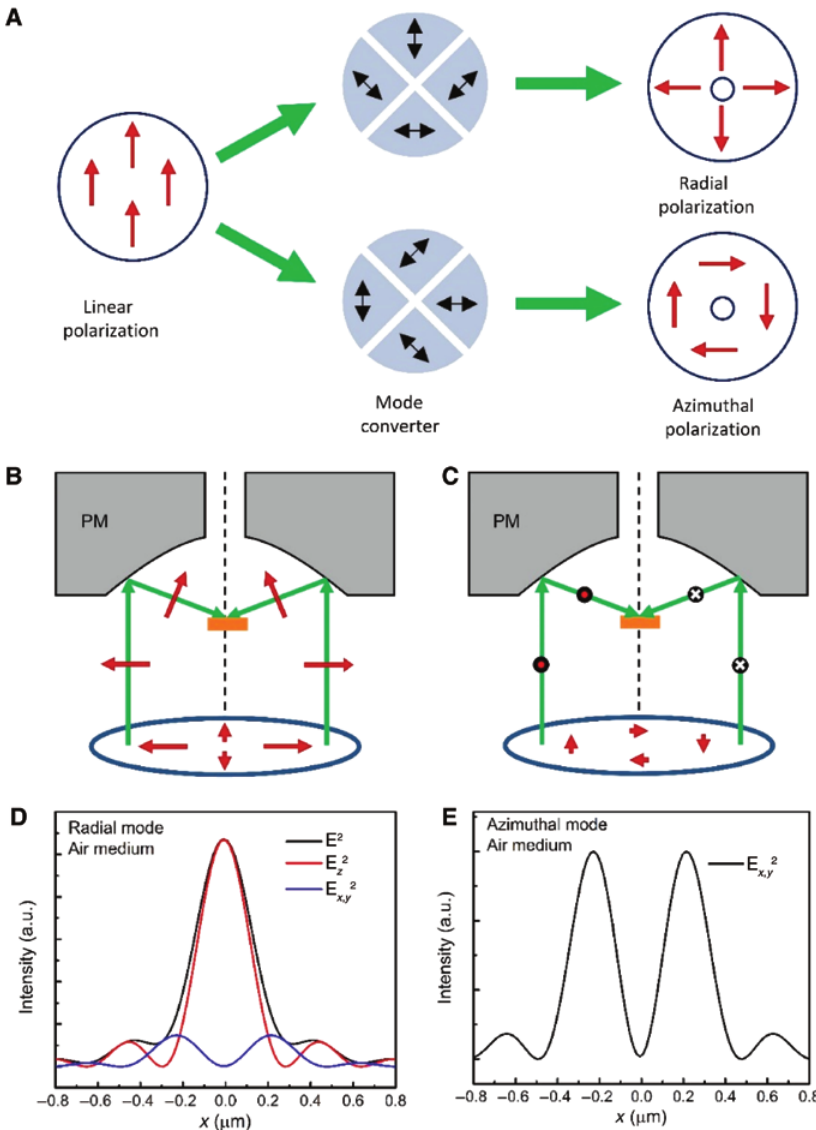
Figure 1: Radial and azimuthal polarization: generation and electric field intensity distribution. (A) Realization of the radial and azimuthal modes from a linearly polarized laser by a mode converter. The red arrows indicate the polarization of the laser beam, and the black two-side arrows stand for the fast axis of the λ /2 wave plate. Parabolic mirror (PM, illustrated as a gray block) focuses (B) the radially polarized laser beam, and (C) the azimuthally polarized laser beam onto the sample (orange block). The green arrows indicate the light propagation direction, while the red ones show the polarization directions. The gray-dashed line is the optical axis of the PM. (D, E) Calculated electric field intensity distributions when a radially polarized beam or an azimuthally polarized beam 2 , E 2 , and E 2 are the field intensity of the transverse component, of the longitudinal component, and the total electric is focused by a PM. E x,y z field intensity, respectively. The results are calculated using an excitation wavelength of 636 nm and air